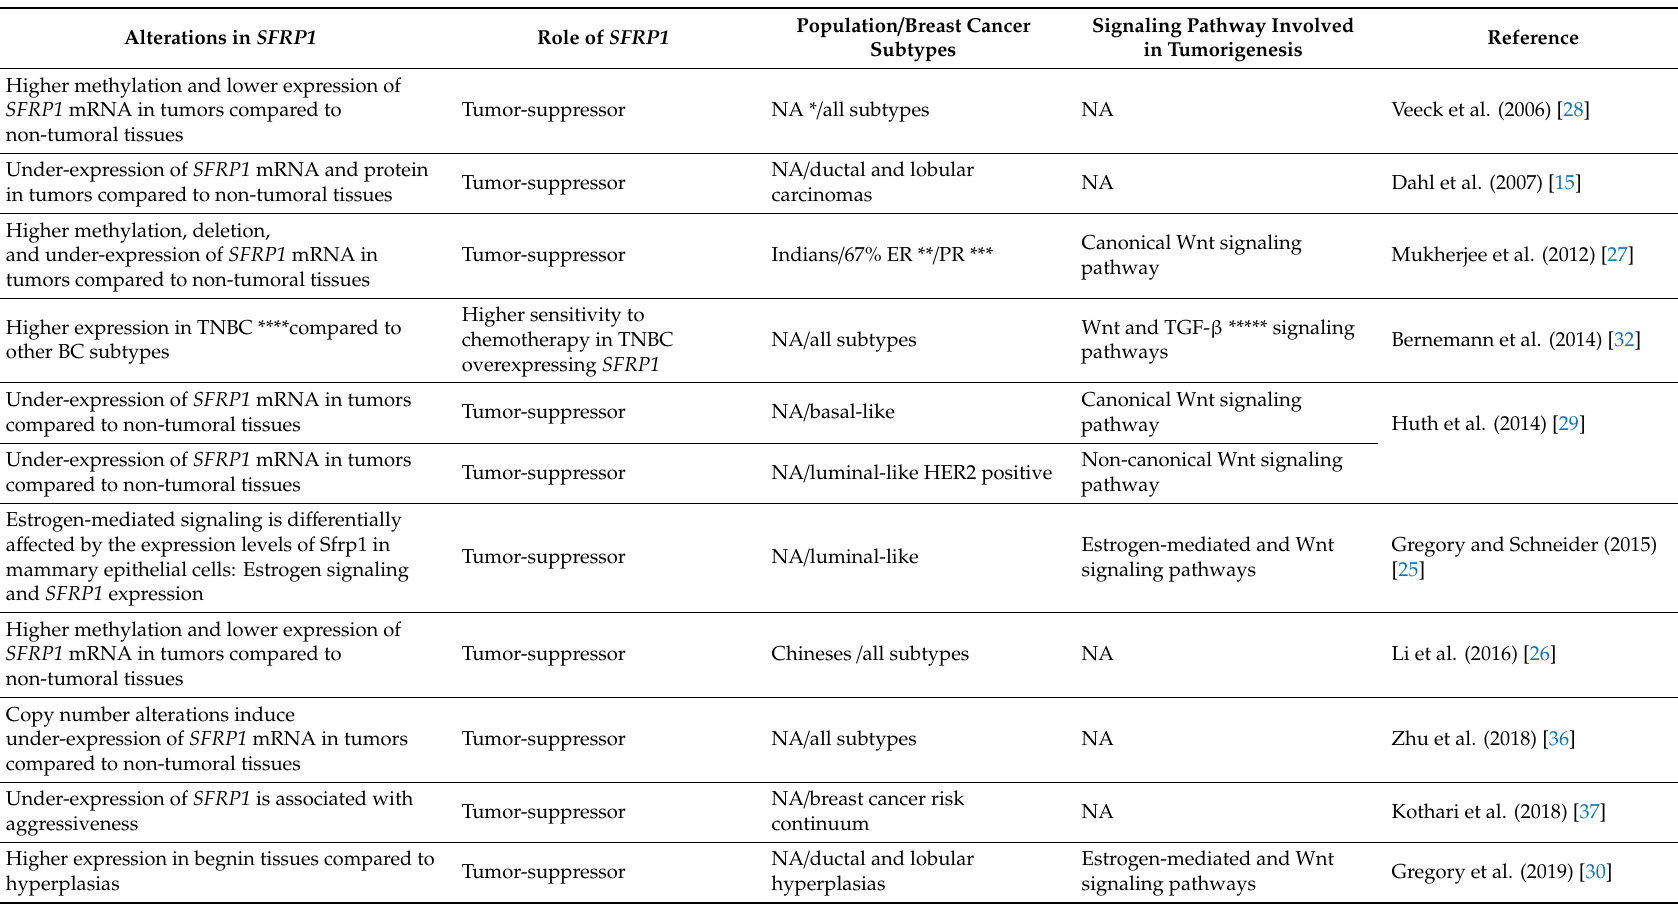
Table 1. Dysregulation of SFRP1 in human breast lesions or cell lines reported in the